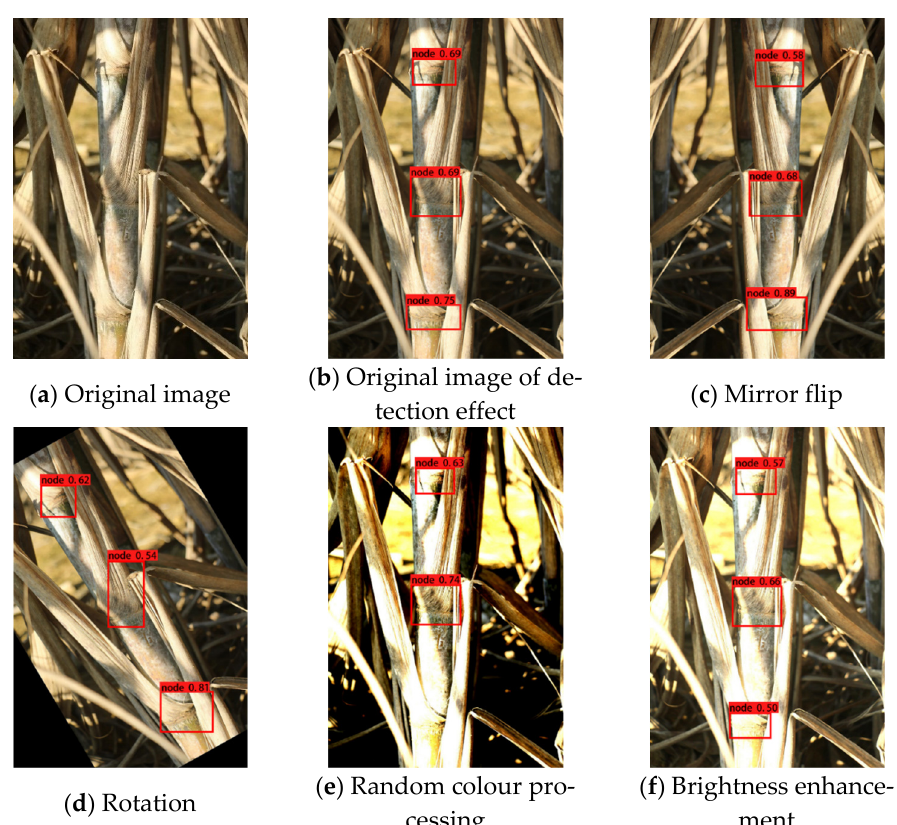
Figure 6. Detection results of 4 kinds of data-expanded images based on YOLO v4.